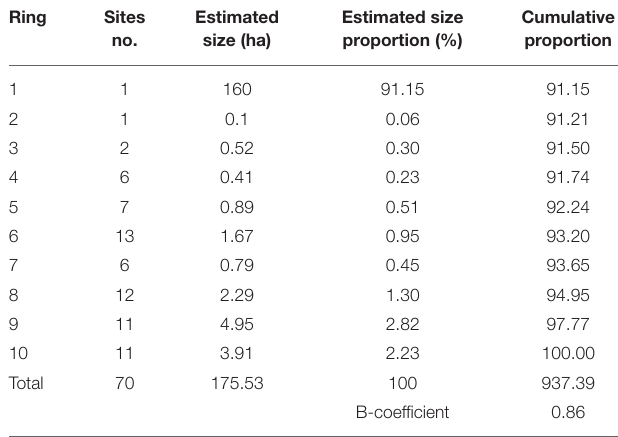
Cumulative proportion